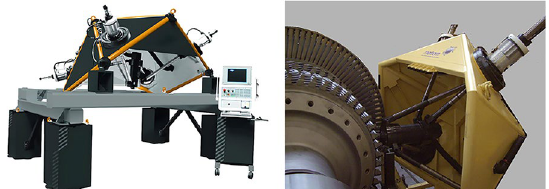
Figure 18 Hybrid machining robot of Tianjin University [63]